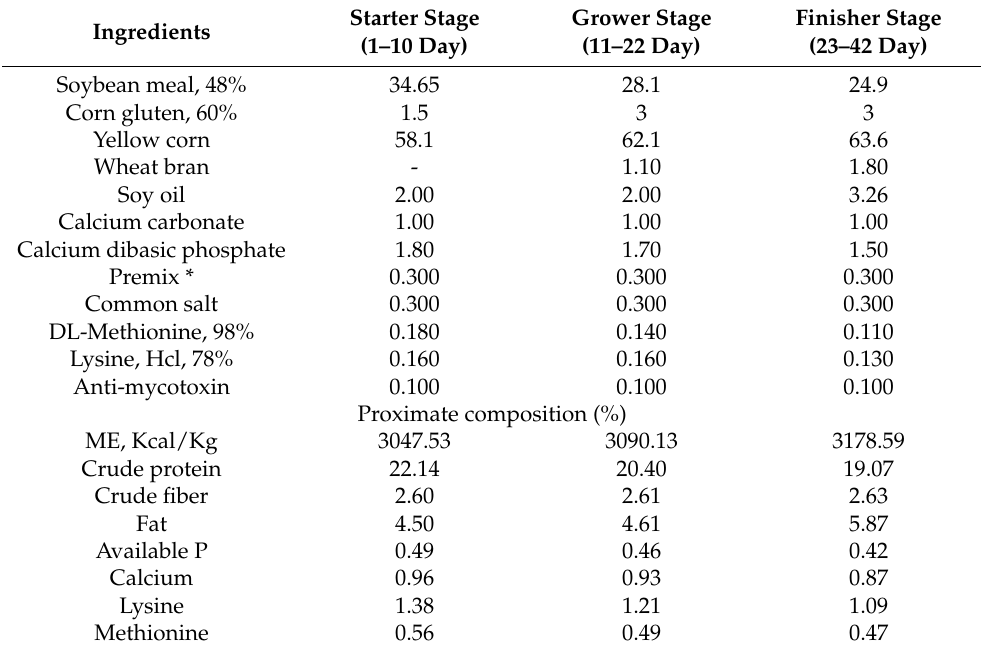
Table 1. Proximate and chemical composition of the basal diets